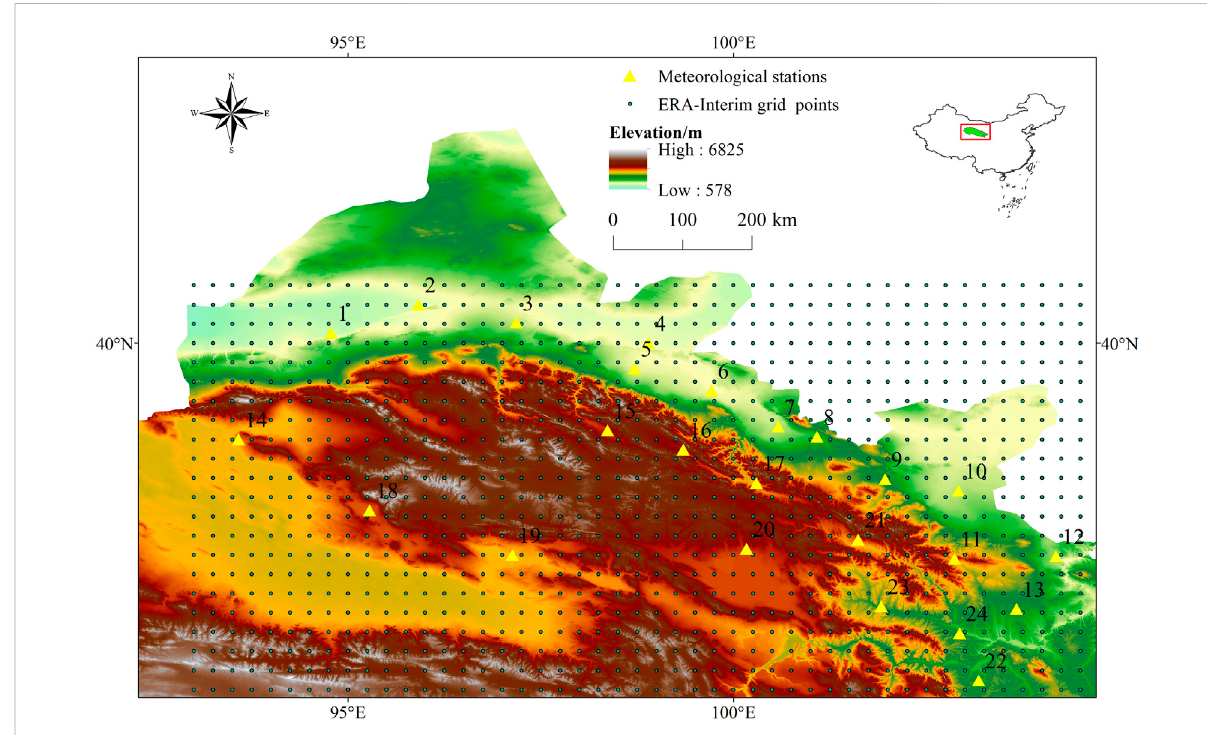
FIGURE 1 Distribution of the ERA-Interim grid points and meteorological stations in the